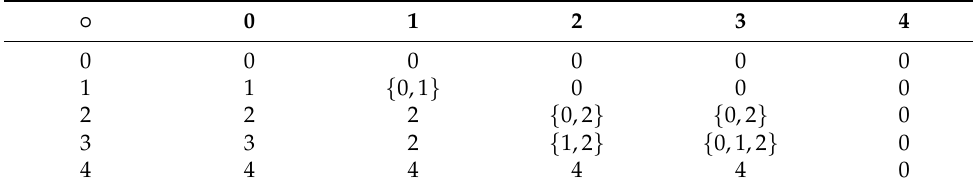
Table 7. Transitive quasi-hyper BZ -algebra.